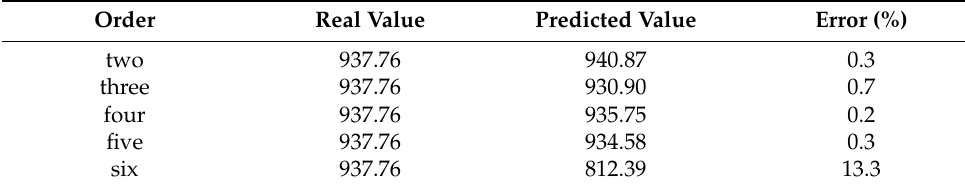
Table 4. The error of different multi-order polynomial for EGT2.